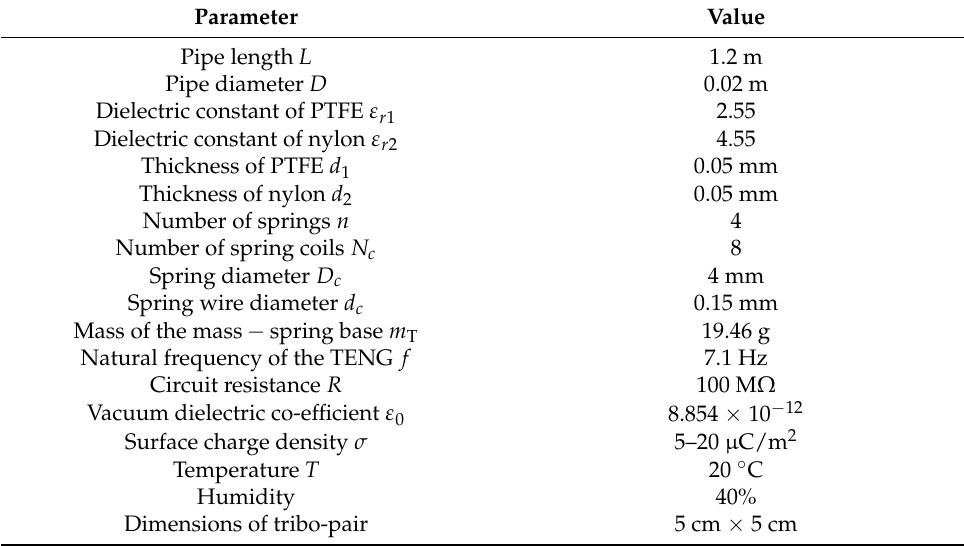
Figure 3. A photo of the experimental setup. ( a ) The experimental setup consists of a PVC pipe, two bearings, an exciter, a galvanometer, a TENG device and external resistances; ( b ) The PTFE layer, nylon layer and the acrylic base. Table 1. Parameters of pipe and the energy harvesting system.